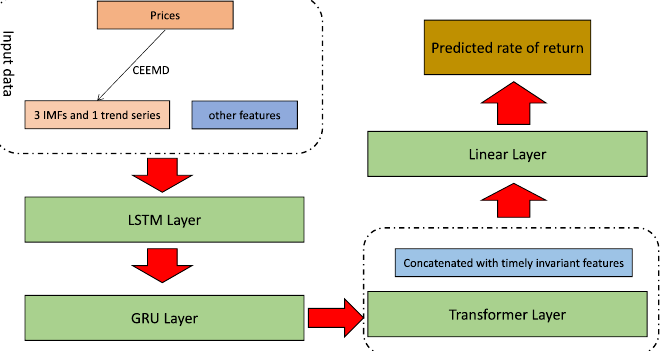
Figure 2. The overview of architecture of FDG-Trans. The series of prices is first decomposed to 4 more stable series, then concatenated with other futures as the input of the LSTM layer, followed by the GRU layer and transformer layer. Finally, the output of transformer concatenated with timely invariant features is passed by a linear layer to get the predicted rate of